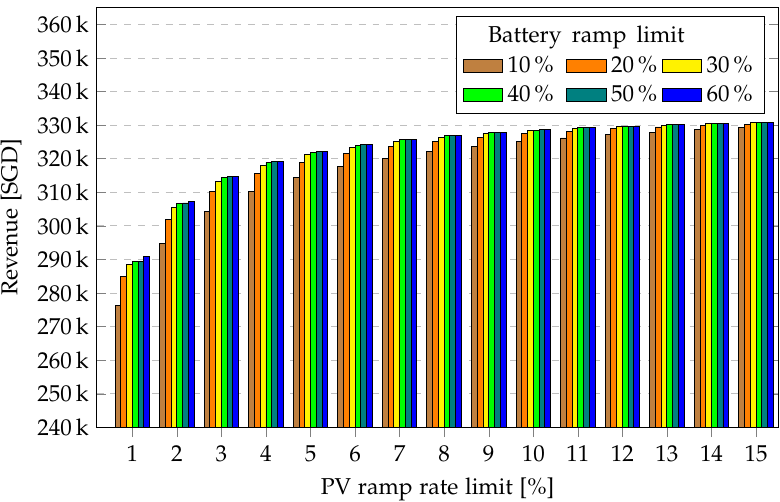
Figure 9. Revenue from PV to grid over ramp rates for various battery ramp limits for one